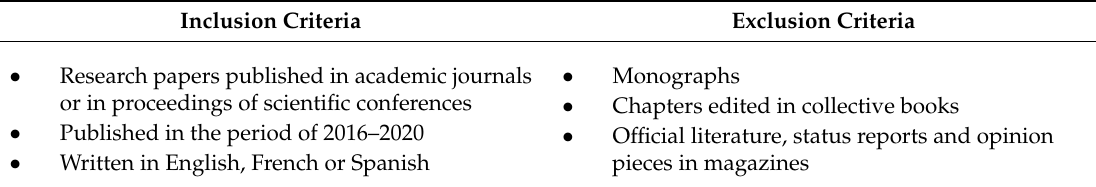
Table 1. Inclusion and exclusion